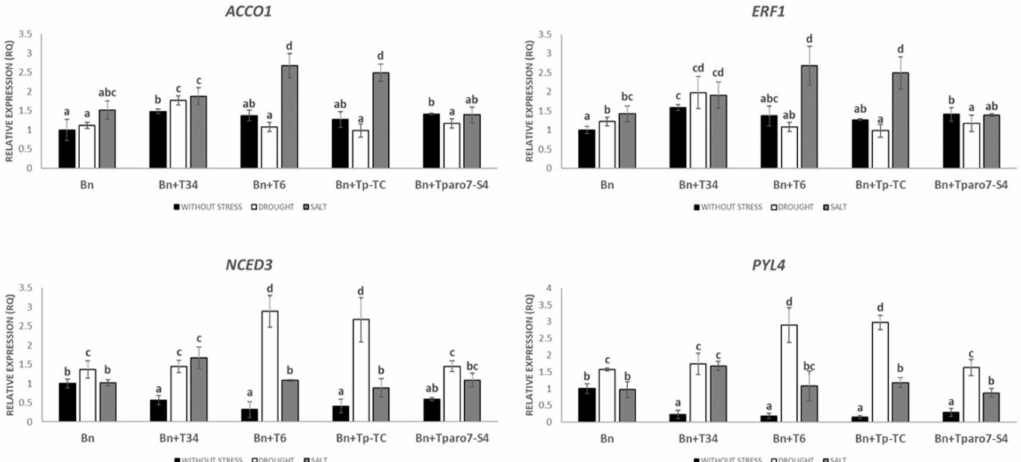
Figure 3. Quantitative reverse transcription polymerase chain reaction (RT-qPCR) analysis of the expression of some tolerance-abiotic-related genes in the roots of rapeseed (Bn) inoculated with T. harzianum ( + T34), T. parareesei ( + T6), T. parareesei transformation control ( + Tp-TC), and the transformants with the silenced Tparo7 gene ( + Tparo7-S4). Values correspond to relative measurements against plants without stress neither Trichoderma -inoculation (2 − ∆∆ Ct = 1). Data are the mean of three biological replicates for each condition with the corresponding standard deviation, and for each biological replicate and condition, roots from five plants were used. One-way analysis of variance (ANOVA) was performed, followed by the Tukey’s test. Di ff erent letters represent significant di ff erences ( p < 0.05) between plants with and without stress and Trichoderma